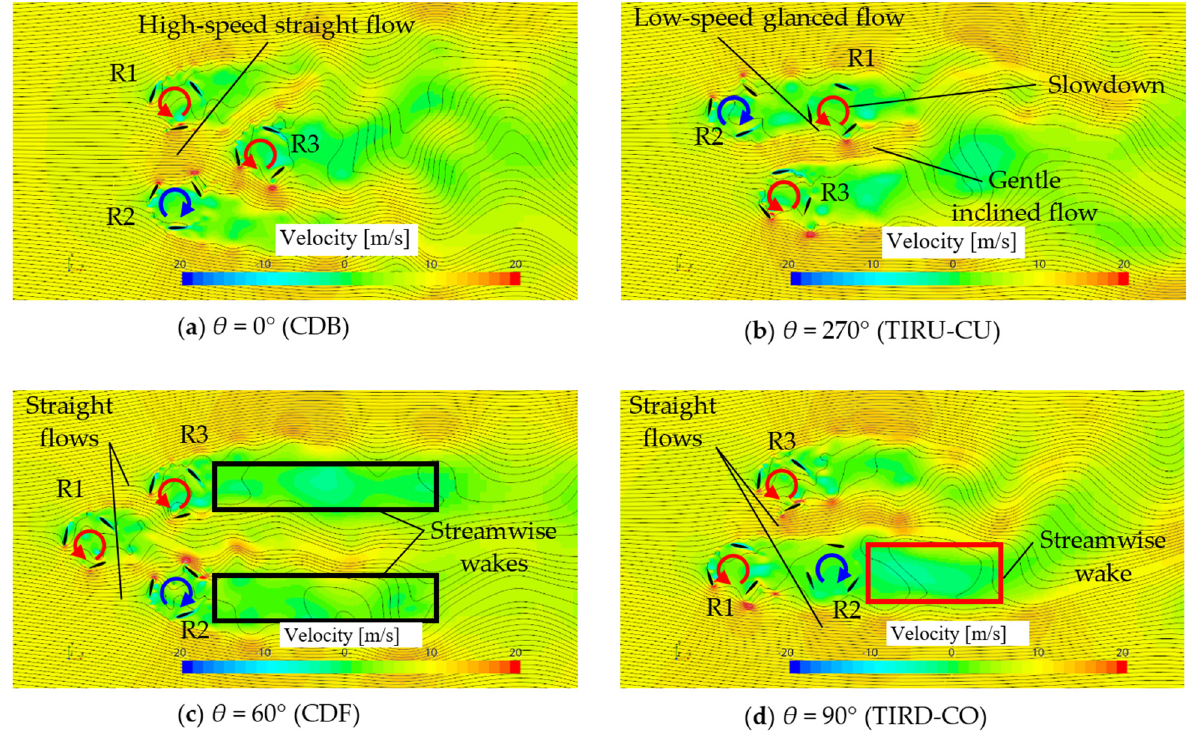
Figure 25. Color contours of flow velocity at g / D = 1 under V = 10 m/s in the 3IR configuration: ( a ) θ = 0°; ( b ) θ = 270°; ( c ) θ = 60°; ( d ) θ = 90°.